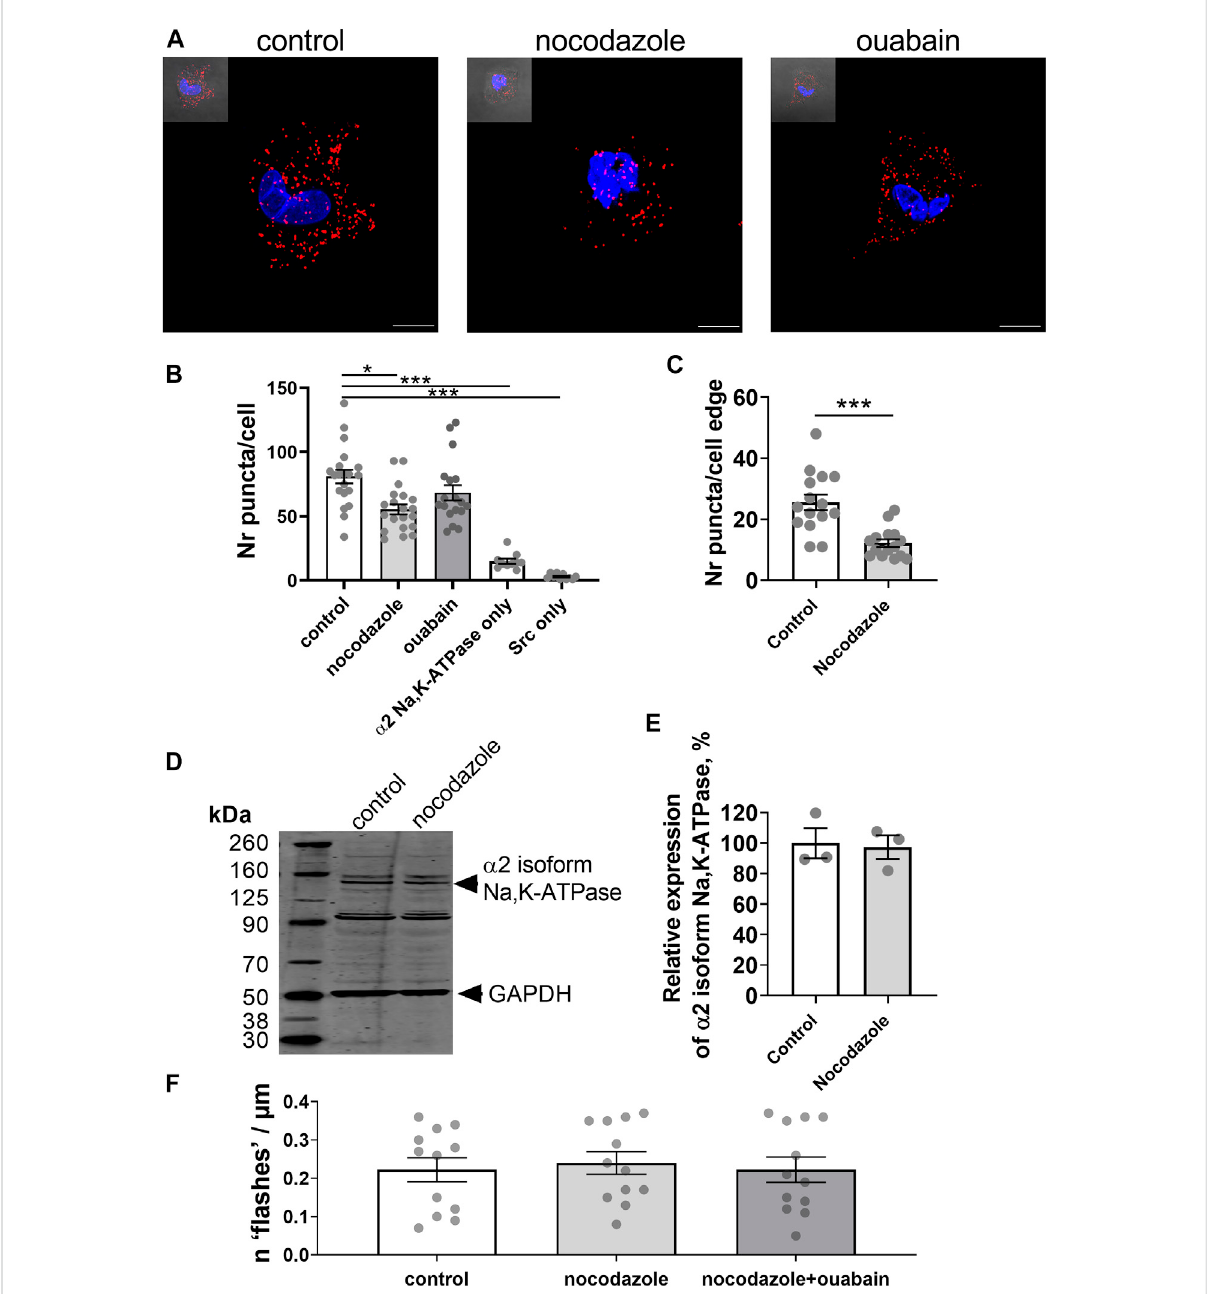
FIGURE 4 Microtubule network enables an interaction between the α 2 isoform Na,K-ATPase and Src kinase, and the generation of Ca 2+ fl ashes in A7r5 cells. Representative images of proximity ligation assay in A7r5 cells under control conditions or treated with nocodazole (10 µM) or with ouabain (10 µM) [ (A) ; scale bar = 10 µm]. Red punctae indicate a close ( < 40 nm) proximity between the α 2 isoform Na,K-ATPase and Src kinase. Nucleiarestained withDAPIandshowninblue.Quanti fi cationoftheredpunctaeintheexperimentasabove[ (B) ; n =18 – 20of4cultures].The redpunctaewerealsocountedonlyatthecellularedge (C) andnocodazolesigni fi cantlydecreasedpunctaeincomparisonwiththecontrol( n =15of 3 cell cultures). Representative Western blot detected the α 2 isoform Na,K-ATPase in lysates of A7r5 cell under control conditions and treated with nocodazole (D) . GAPDH protein was stained for loading control. Quanti fi cation of the α 2 isoform Na,K-ATPase expression under control conditions and after incubation with nocodazole [ (E) ; n = 3 of 3 cultures]. Nocodazole (10 µM) abolished the ouabain-induced Ca 2+ fl ashes [ (F) ; n = 12 of 4 cultures]. * and ***, p < 0.05 and 0.001 (Kruskal – Wallis ’ test followed by Dunn ’ s multiple comparison test in B, unpaired t test in C and E, and one- way ANOVA followed by Sidak ’ s multiple comparisons test in